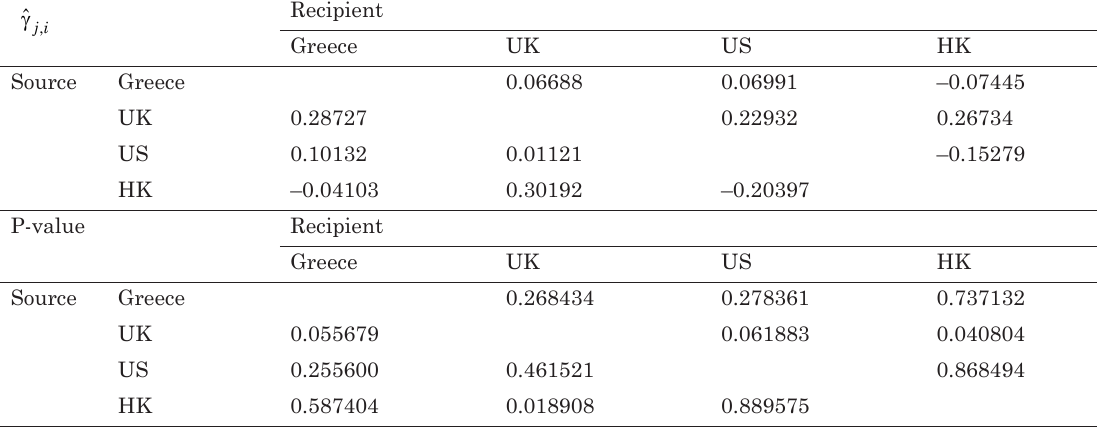
Table 5. The result of the FRM test on the real estate